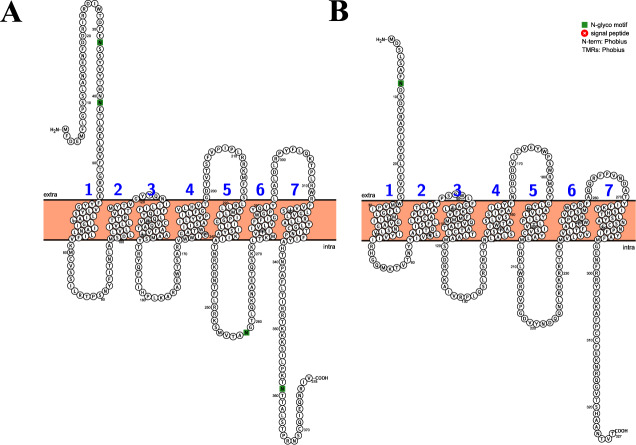
Sequence, topology and annotations of Apostichopus japonicus kisspeptin receptors (A: AjKissR1, B: AjKissR2) visualized using the Protter webservice.http://wlab.ethz.ch/protter/start/.